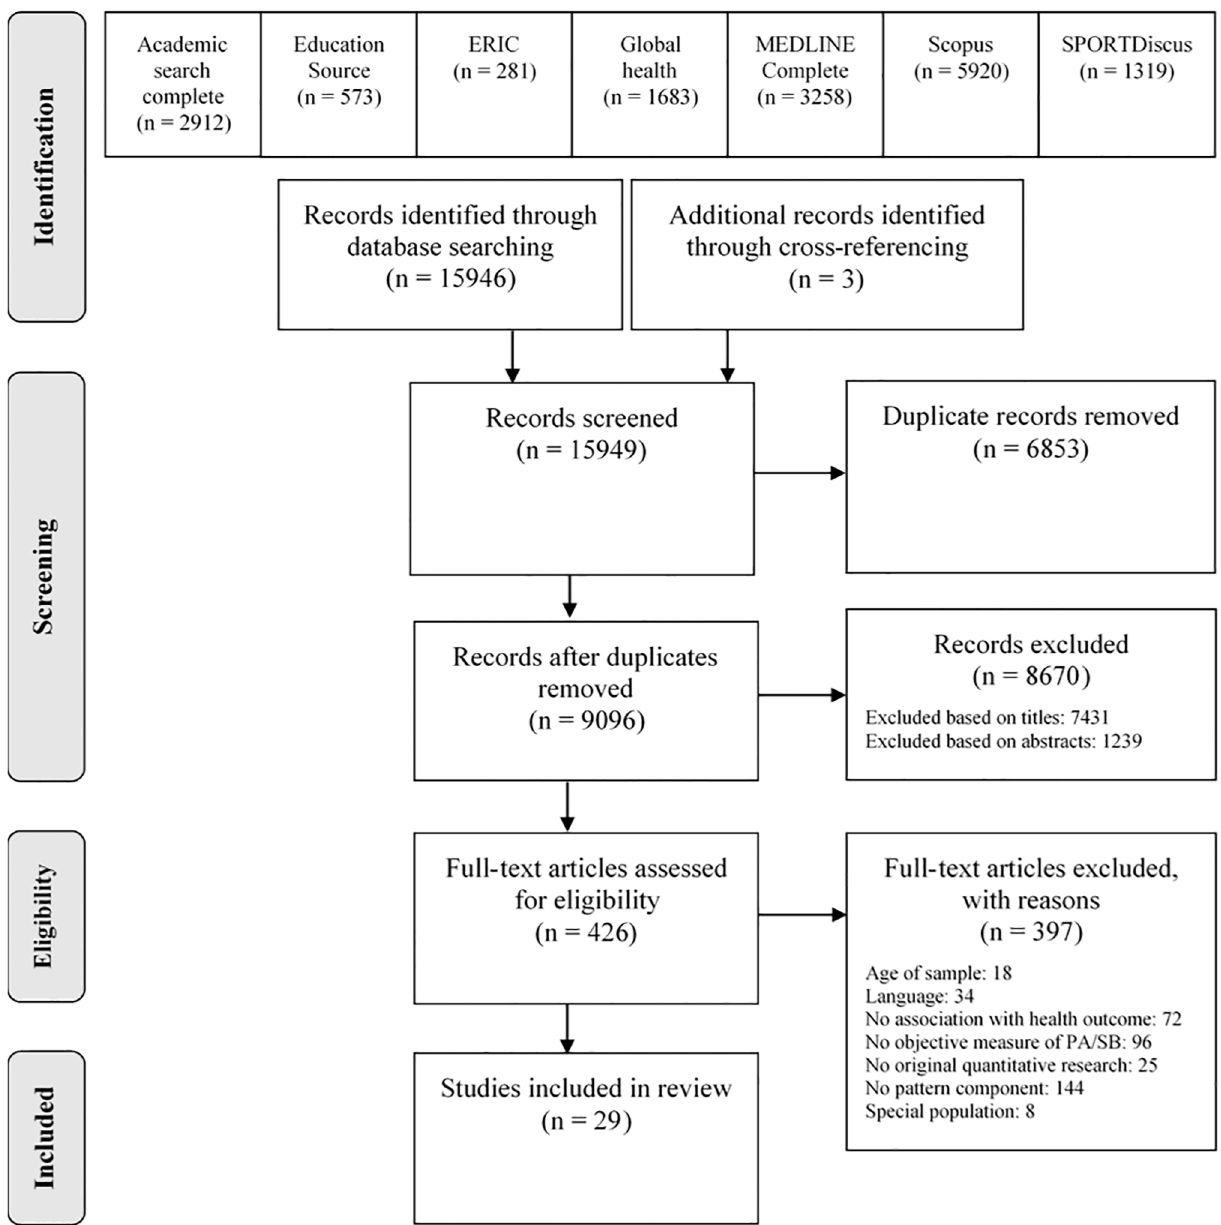
Fig 1. Flow chart of the systematic literature search. From: PRISMA Group [29].